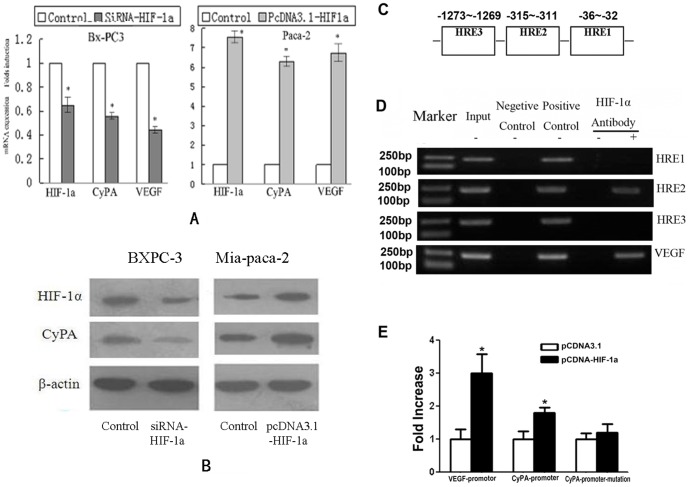
CypA expression is regulated by HIF-lα.
A. HIF-lα and CypA relative mRNA expression levels in different groups. HIF-lα and CypA relative mRNA expression levels in pancreatic cancer cell lines Mia-paca-2 and BXPC3 were determined by real-time PCR analysis. β-actin cDNA served as the internal control. Expression levels in both untransfected cell lines were set as 1. Columns, mean of triplicate samples from two different experiments; bars, SE. *: P<0.05. B. HIF-lα and CypA protein expression levels in different groups. HIF-lα and CypA protein expression levels were determined by western blot analysis. β-actin served as the loading control. Expression levels in both untransfected cell lines were set as 1. Columns, mean of triplicate samples from two different experiments; bars, SE. *: P<0.05. C. Binding of HIF-lα to the CypA promoter in BXPC3.: screening of the 5-flanking region of the CypA gene revealed 3 potential HIF-1α binding sites (−32∼−36 −311∼−315 −1269∼−1273) relative to the start site of transcription. D. ChIP results in different groups. ChIP assay was performed and the promoter fragment binding sites (−311∼−315) was specifically co-immuno-precipitated by anti-HIF-lα but not the control IgG or non-antibody. In chromatin fraction pulled down by anti-HIF-1α antibody, the CypA promoter PCR fragments binding sites (−32∼−36 or −1269∼−127) hardly has been detected. E. Dual luciferase results in different groups. The results showed that the full-length CypA promoter activity (CypA-promotor) increased significantly after over expression of HIF-1α compared to that treated with plasmids alone (P<0.05). But the mutant CypA promoter (CypA-promotor-mutation) had not increased, which was used as negative control. VEGF luciferase reporter construct (VEGF-promotor) was used as positive control for the HIF-1α response. Over-expression of HIF-1α increased about 3-fold of the VEGF promoter activity compared to controls (P<0.05).